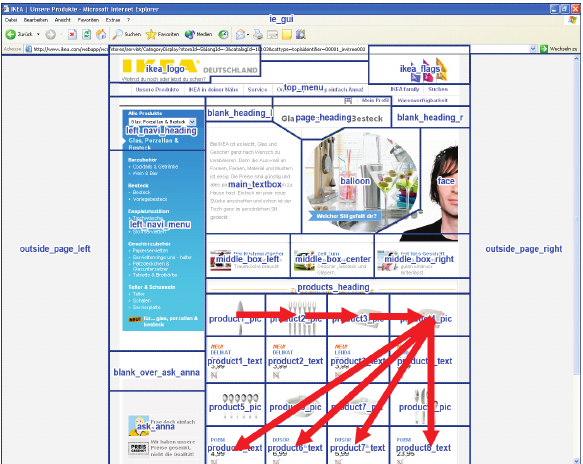
Figure 14. Four IKEA patterns with a common beginning, involving 5 ROIs each, occurring between 5 and 6 times each, 3 of the patterns initially in presentation 1, the other initially in presentation 6 (participant